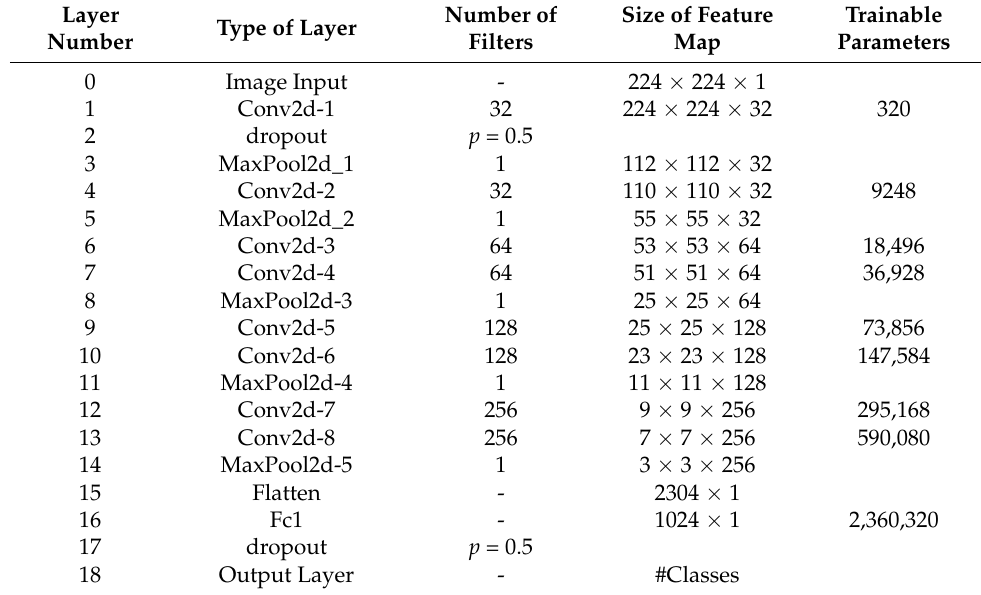
Table 1. Description of our proposed base network